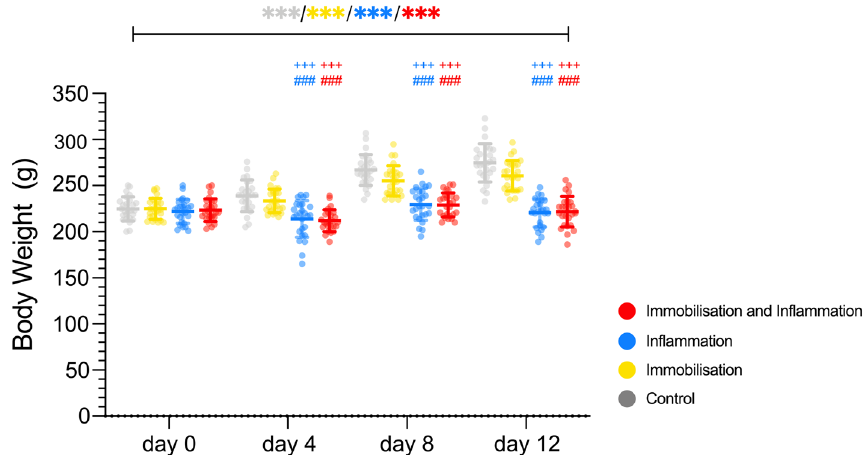
Fig. 3 Body weight in gram. The control (mean [SD]; day 0: 224.9 [13.3], day 4: 239.5 [17.3], day 8: 267.8 [16.7], day 12: 276.0 [20.0]; p < 0.001), immobilisation (mean [SD]; day 0: 225.0 [11.4], day 4: 233.5 [12.9], day 8: 255.2 [16.3], day 12: 260.8 [16.5]; p < 0.001), inflammation (mean [SD]; day 0: 222.2 [13.0], day 4: 214.1 [19.5], day 8: 229.8 [17.5], day 12: 220.6 [15.3]; p < 0.001) as well as immobilisation and inflammation (mean [SD]; day 0: 223.8 [12.8], day 4: 213.0 [13.6], day 8: 230.0 [14.4], day 12: 221.2 [15.9]; p < 0.001) group showed a significant change over time. The increase over time in the control and immobilisation group led to significantly higher values in comparison with either the inflammation or immobilisation and inflammation group on days 4, 8 and 12 ( p < 0.001 for all three timepoints and 3 comparisons). The number of identical symbols at the top of the error bars indicate the significance level: one < 0.05; two < 0.01 and three < 0.001. *Significant difference over time with the colour of the symbol indicating the respective group. # Significant difference to the control group at the specific time point. + Significant difference to the immobilisation group at the specific time point. § Significant difference to the inflammation group at the specific time